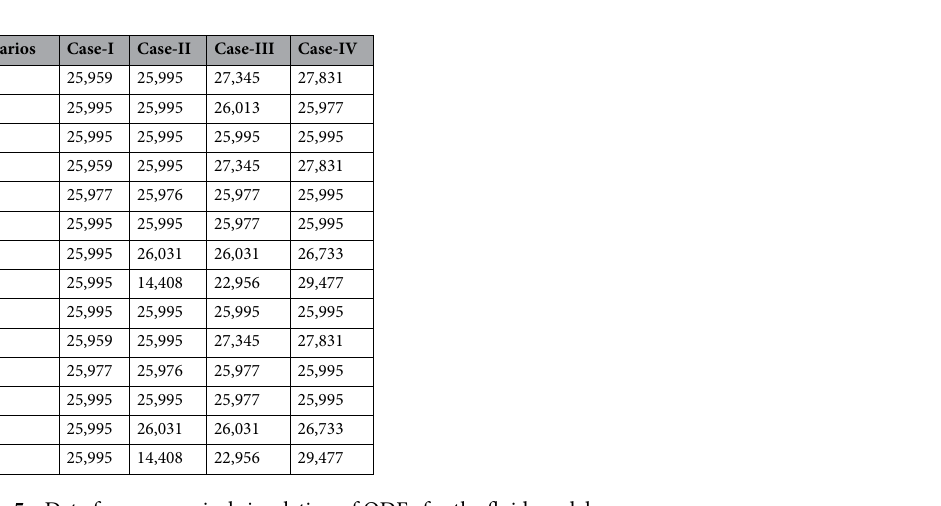
Table 5. Data from numerical simulation of ODEs for the fluid